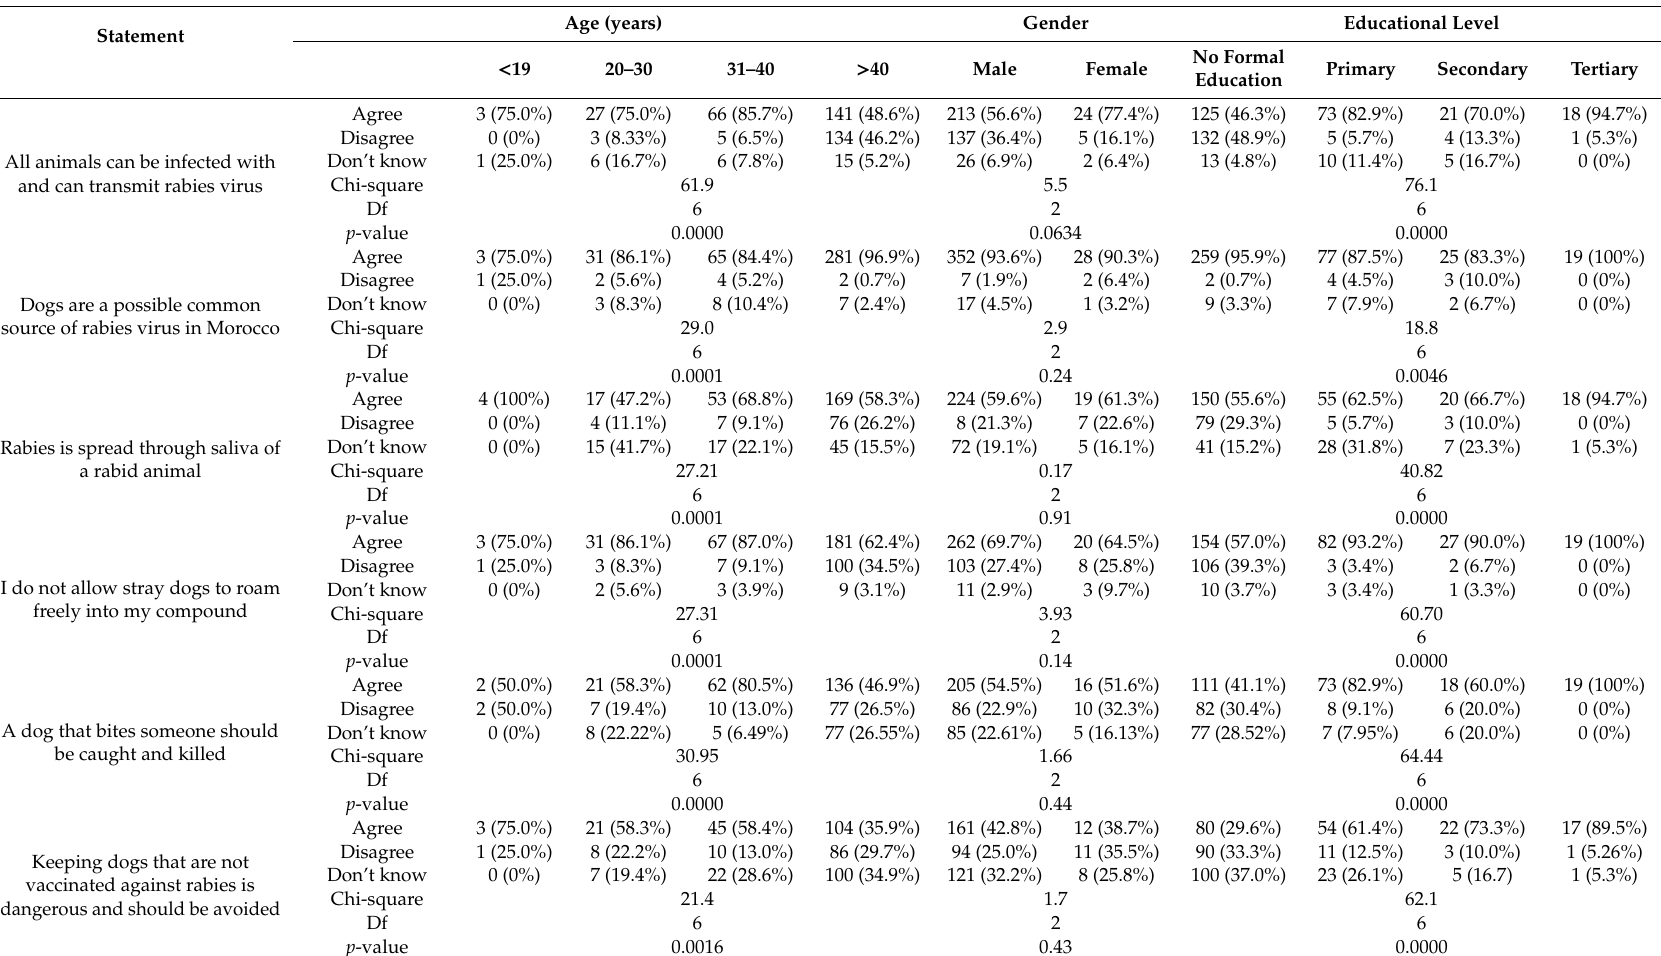
Table 5. Association between knowledge, attitudes, and practices (KAP) and selected sociodemo graphic parameters among study